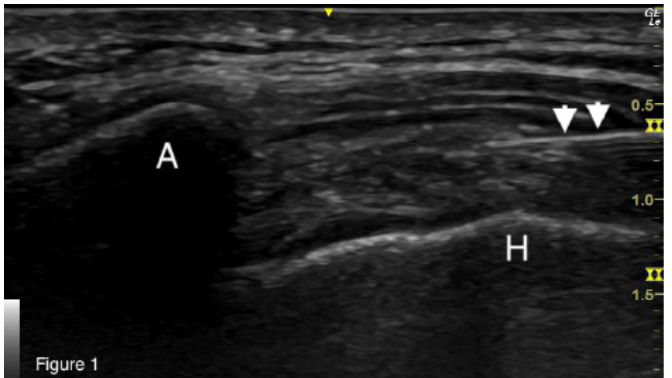
Image 1. Ultrasound still image demonstrating ultrasound-guided approach to injection of the subacromial/subdeltoid bursa. (A: acromion; H: humeral head; arrowheads: needle.)